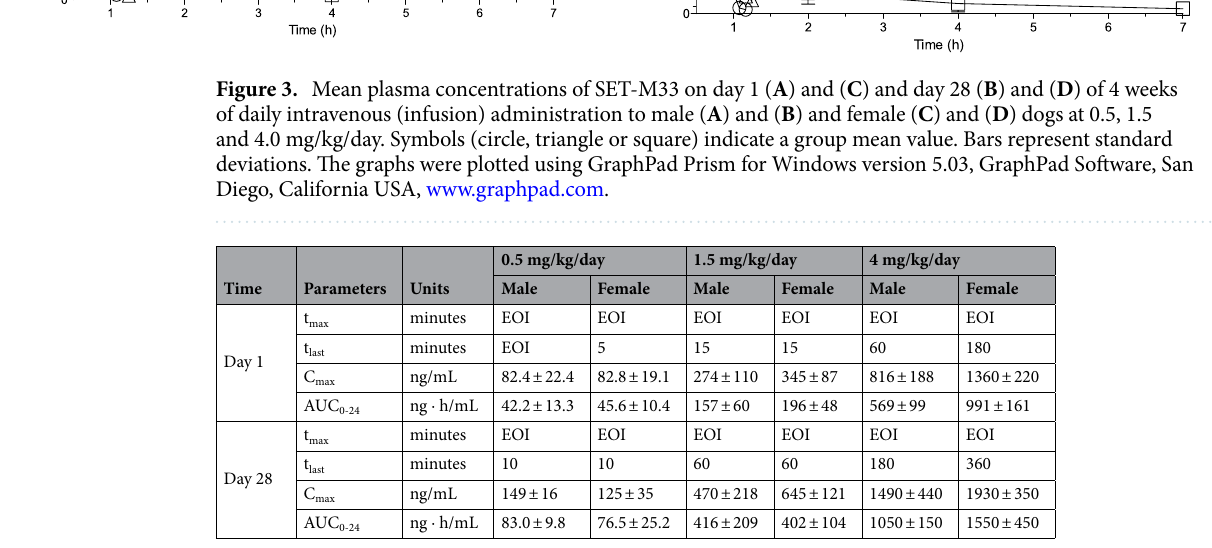
Table 8. Pharmacokinetic parameters of SET-M33 on day 1 and day 28 of 4 weeks of daily intravenous (infusion) administration to male and female beagle dogs at 0.5, 1.5 and 4.0 mg/kg/day (group mean values ± standard deviation of C max and AUC 0-24 ). AUC 0-24 area under the plasma concentration–time curve in 24-h dosing intervals, C max maximum plasma concentrations, EOI end of infusion, t last time point of the last quantifiable plasma concentration, t max time at which C max occurred. Statistical analysis is not applicable to these